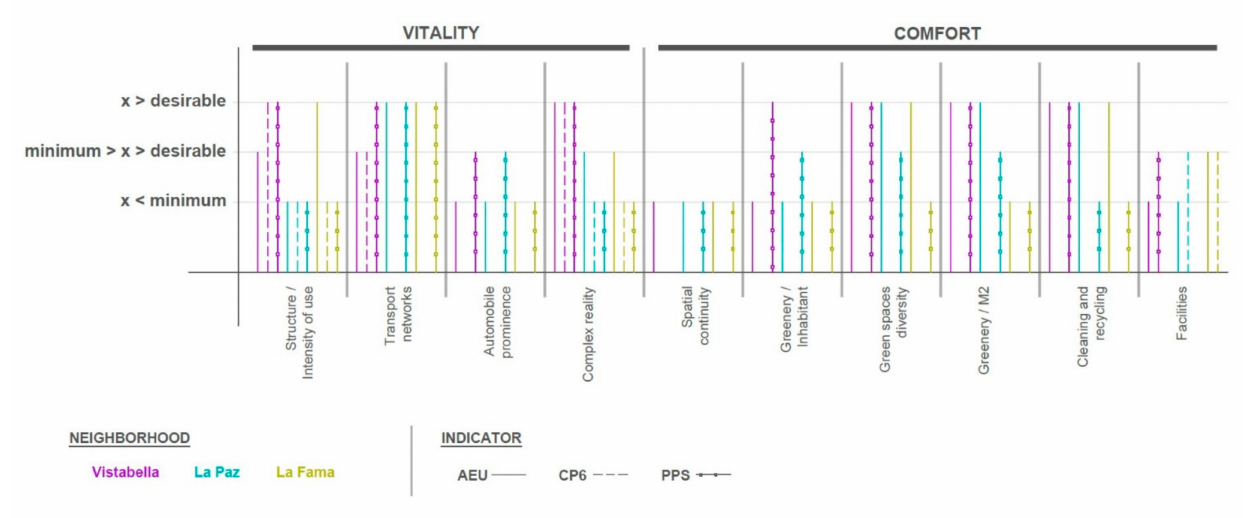
Figure 10. Summary of related indicators. Authors’